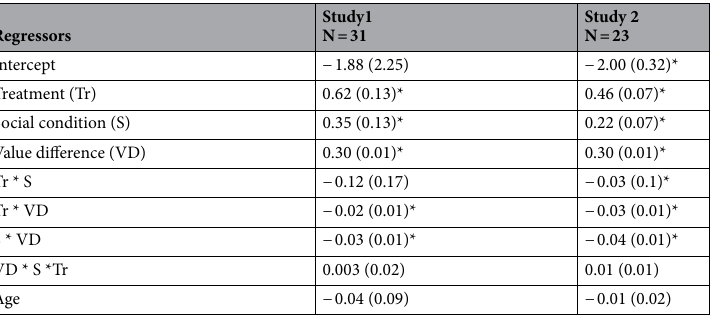
Table 1. Mixed-effects Bayesian regression model. Point posterior parameter estimates (mean) and posterior parameter estimate uncertainty (standard deviation) for the Bayesian mixed-effects logistic regressions of the two studies. Treatment (Tr) codes for the citalopram (1) and placebo (0) session. Social condition (S) codes for the social (1) and nonsocial (0) contexts. VD = difference of the gamble’s values. *Posterior parameter estimates for which the 89% highest density interval does not include zero.